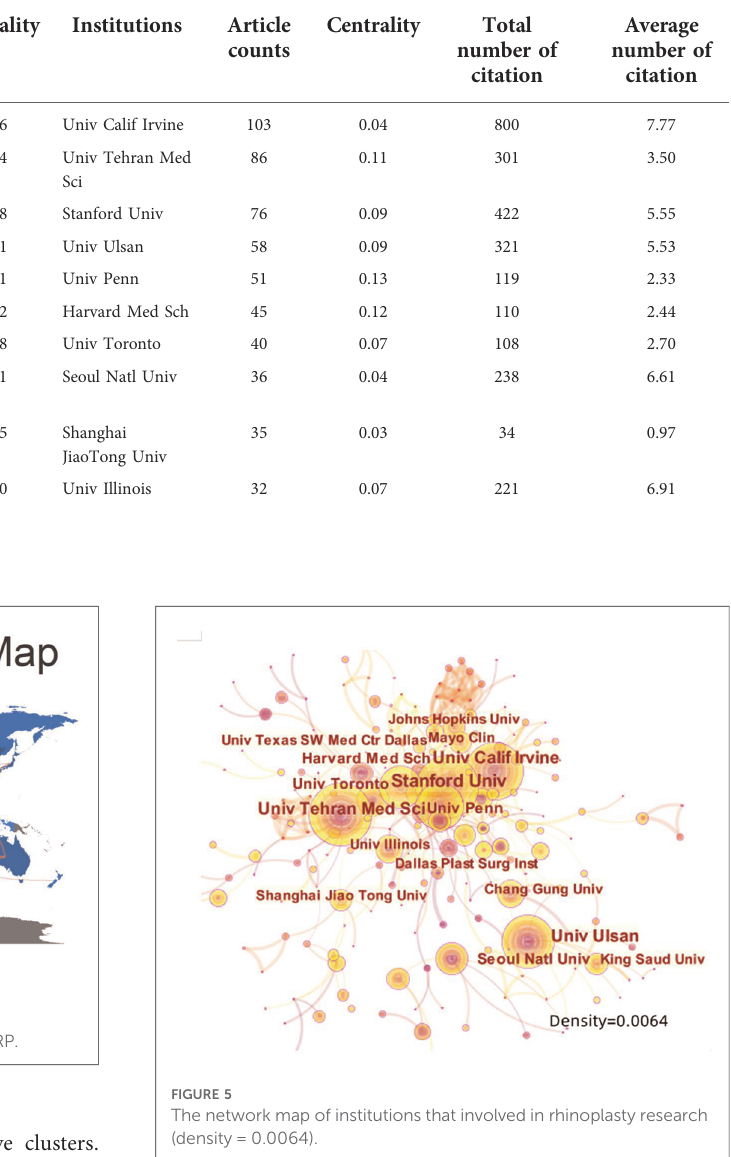
TABLE 1 The top 10 countries/regions and institutions contributing to publications in rhinoplasty research.